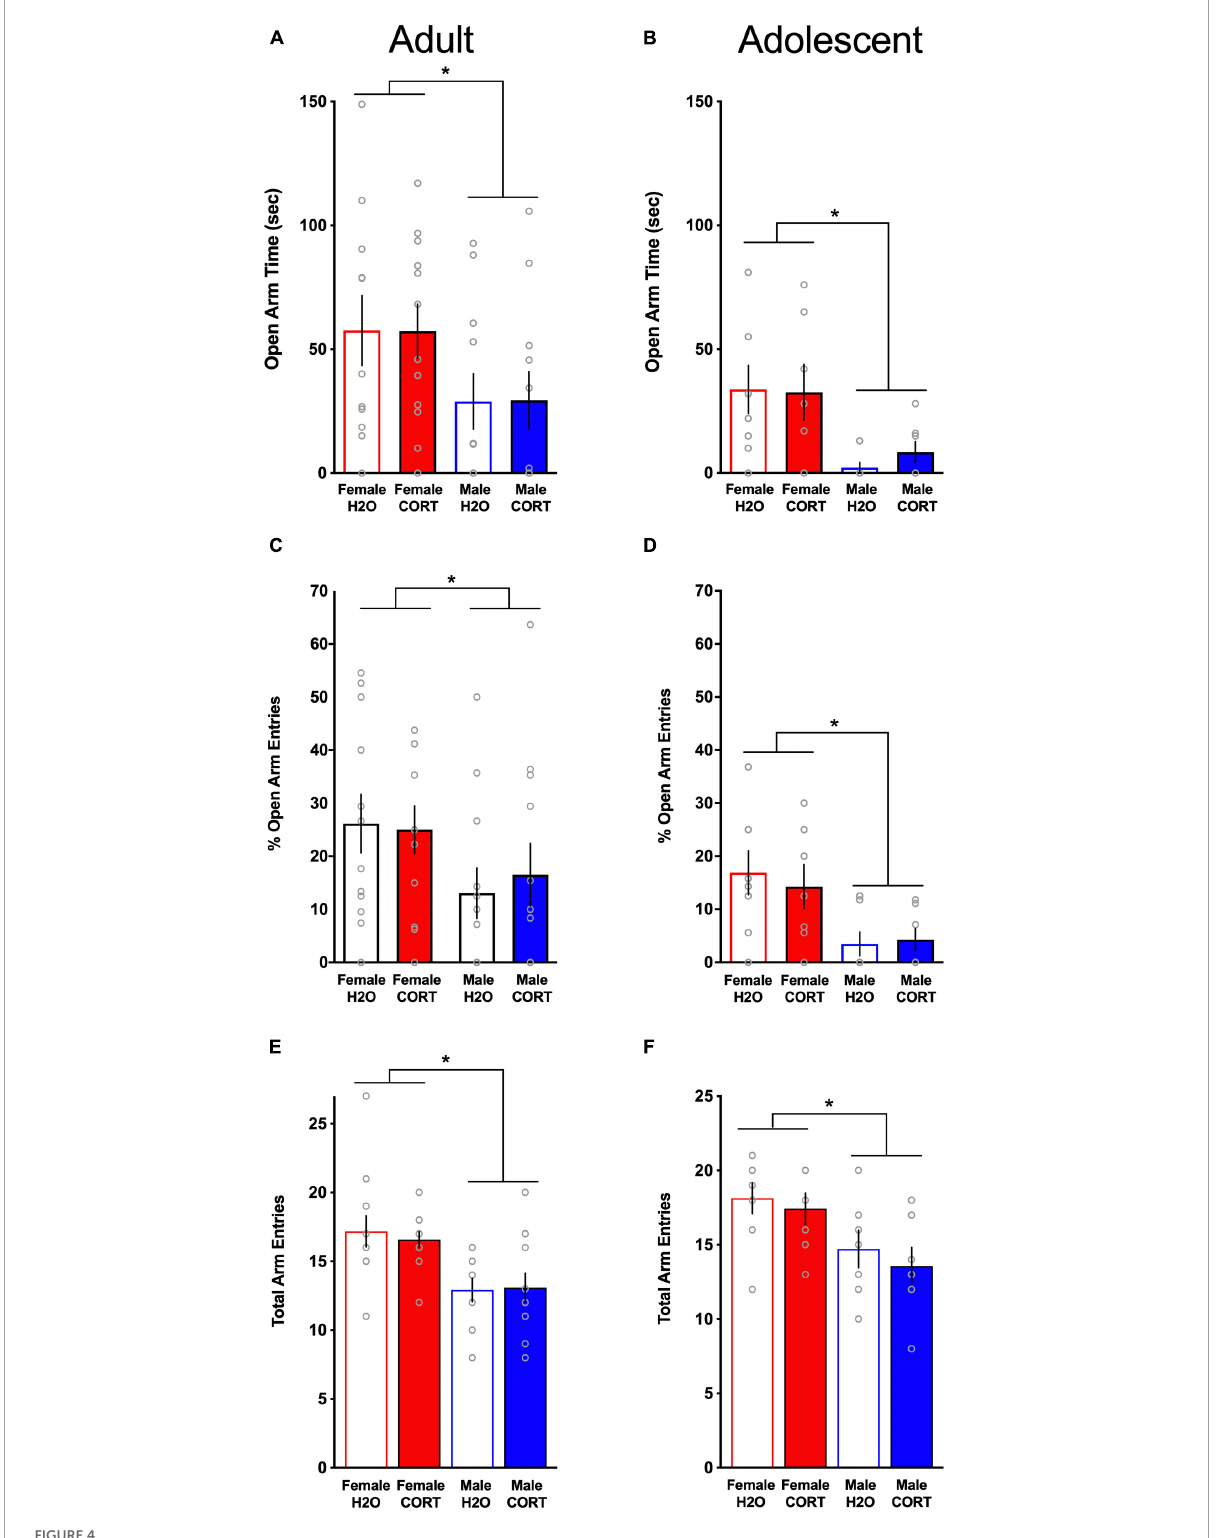
FIGURE4 Anxiety-like behavior is reduced in females relative to males, but is not altered by chronic CORT treatment. In both age groups, females spent significantly more time in the open arms [ (A) adults; (B) adolescents], had significantly higher percent open arm entries [ (C) adults; (D) adolescents], and exhibited more total arm entries [ (E) adults; (F) adolescents] compared to males. * p < 0.005 (male vs.